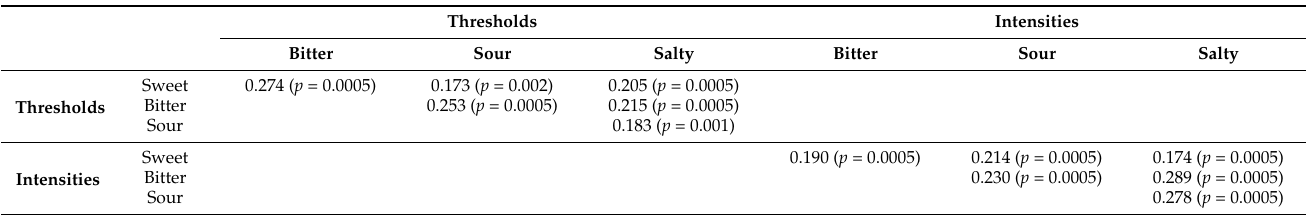
Table 3. Correlation between sensitivities for each of the basic tastes evaluated, either by detection thresholds or perception intensity.